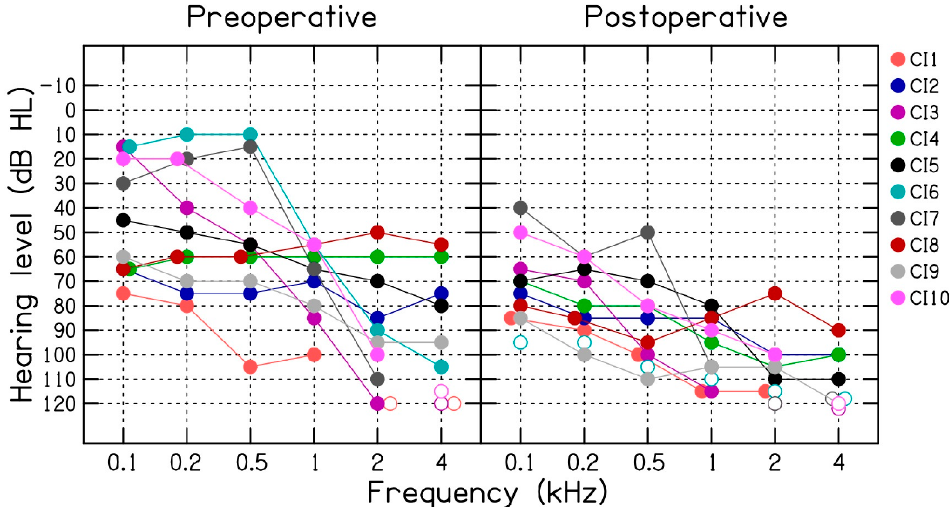
Figure 1. Pre and postoperative audiometric air-conduction thresholds (dB HL) measured for the ten (CI1 to CI10) cochlear implant patients.